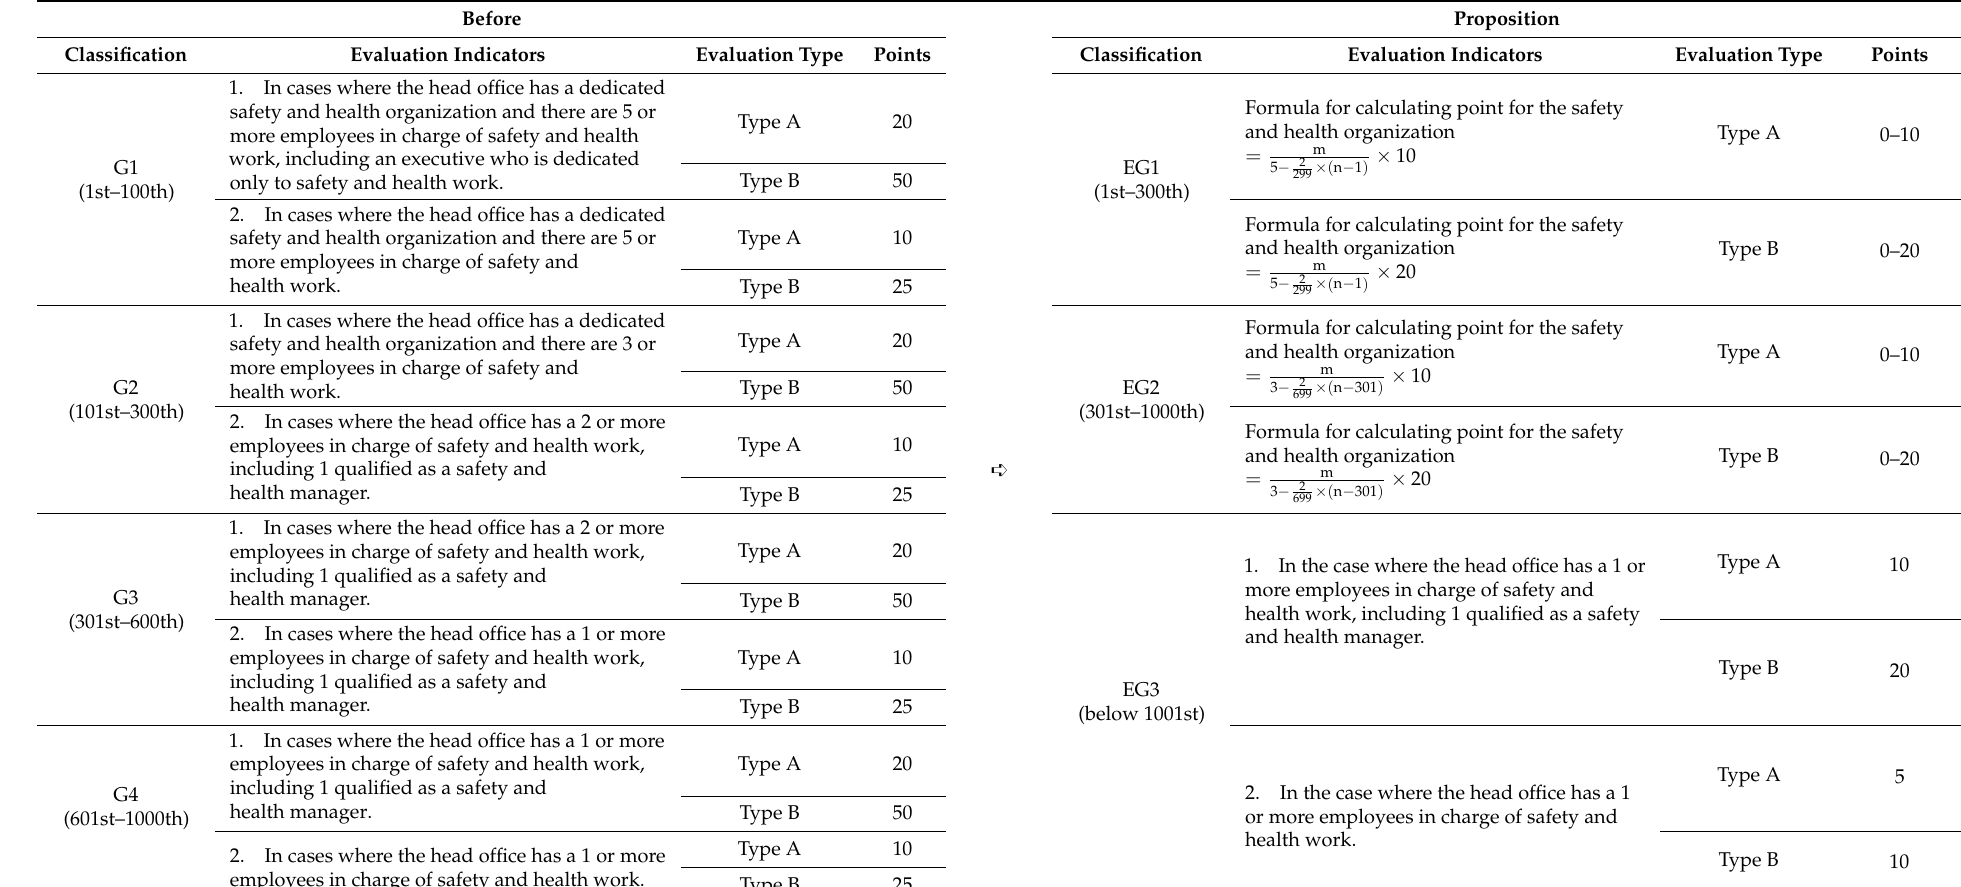
Table 12. Evaluation details for safety and health